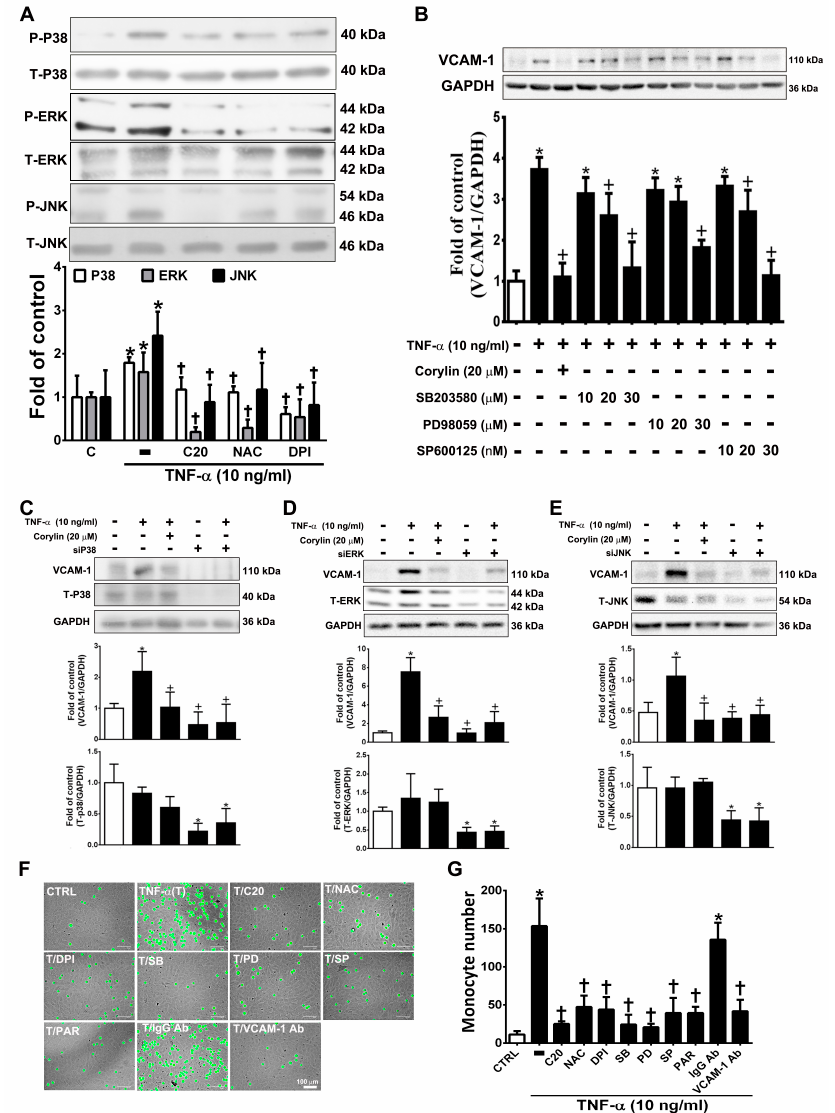
Figure 4. Corylin reduces VCAM-1 expression in TNF- α -treated VSMCs through ROS / MAP kinase inhibition. VSMCs were treated with 20 µ M corylin, 2 mM NAC or 10 µ M DPI for 1 h and then incubated with or without 10 ng / mL TNF- α for 15 min. ( A ) Phosphorylated P38, ERK, and JNK levels were examined by Immunoblot analysis. Total ERK (T-ERK), total P38 (T-P38), and total JNK (T-JNK) were used as an internal control for sample loading. ( B ) VSMCs were pretreated (1 h) with corylin (20 µ M), a P38 inhibitor (SB203580; SB; 10, 20, or 30 µ M), PD98059 (PD; 10, 20, or 30 µ M), or a JNK inhibitor (SP600125; SP; 10, 20, or 30 nM) and then treated with 10 ng / mL TNF- α for 24 h. Western blot analysis for VCAM-1 and quantification of VCAM-1 to GAPDH in VSMCs. ( C – E ) After P38, ERK and JNK silencing, cells were treated with TNF- α and corylin. VCAM-1 expression was determined by Western blot analysis. Total P38 (T-P38), total ERK (T-ERK), and total JNK (T-JNK) proteins were used to examine the siRNA e ff ects. GAPDH was used as an internal control for sample loading. ( F , G ) Confluent VSMCs were pretreated (1 h) with 20 µ M corylin (C20), 30 µ M SB203580 (SB), 30 µ M PD98059 (PD), 30 nM SP600125 (SP), 10 µ M parthenolide (PAR), and 1 µ g / mL anti-VCAM-1 antibody or IgG and then treated with 10 ng / mL TNF- α (T) for 24 h. BCECF / AM-labeled U937 cells were added and cocultured for another 1 h. The adherent U937 cells were counted to evaluate the overall VCAM-1 expression level. The data are shown as the mean ± SD. * p < 0.05 versus the untreated group (CTRL). † p < 0.05 versus the TNF- α -treated group. Scale bars = 100 µ m ( F